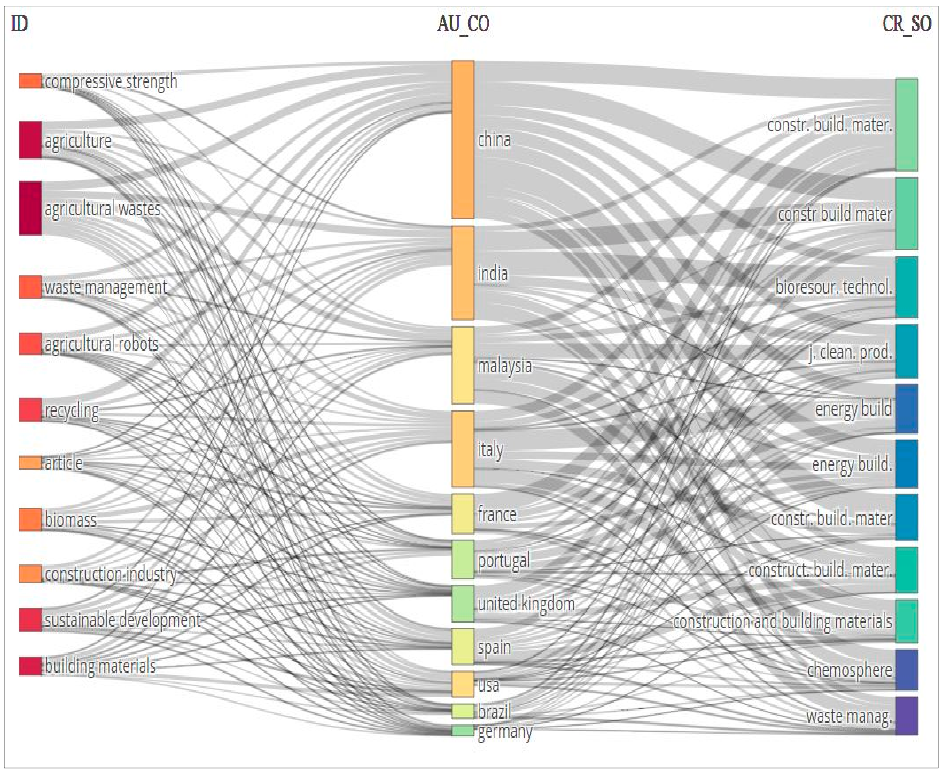
Figure 1. Sankey diagram of country, keyword, and source of researched topics.